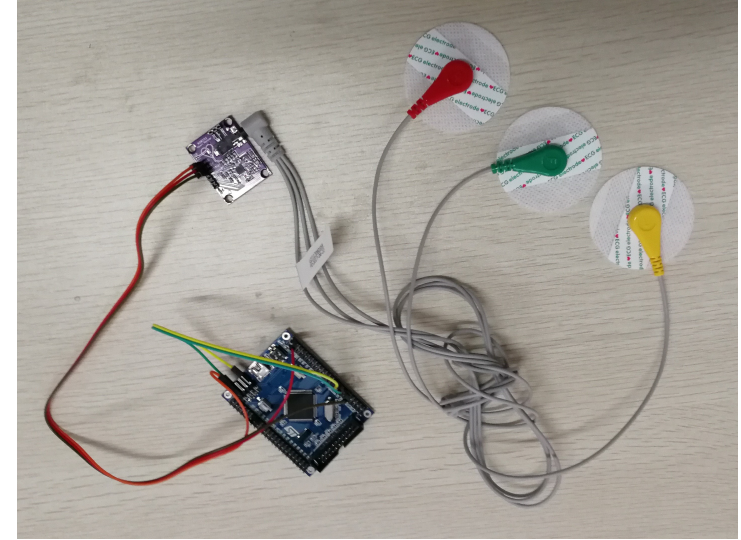
Figure 3. Devices of a wearable ECG collecting